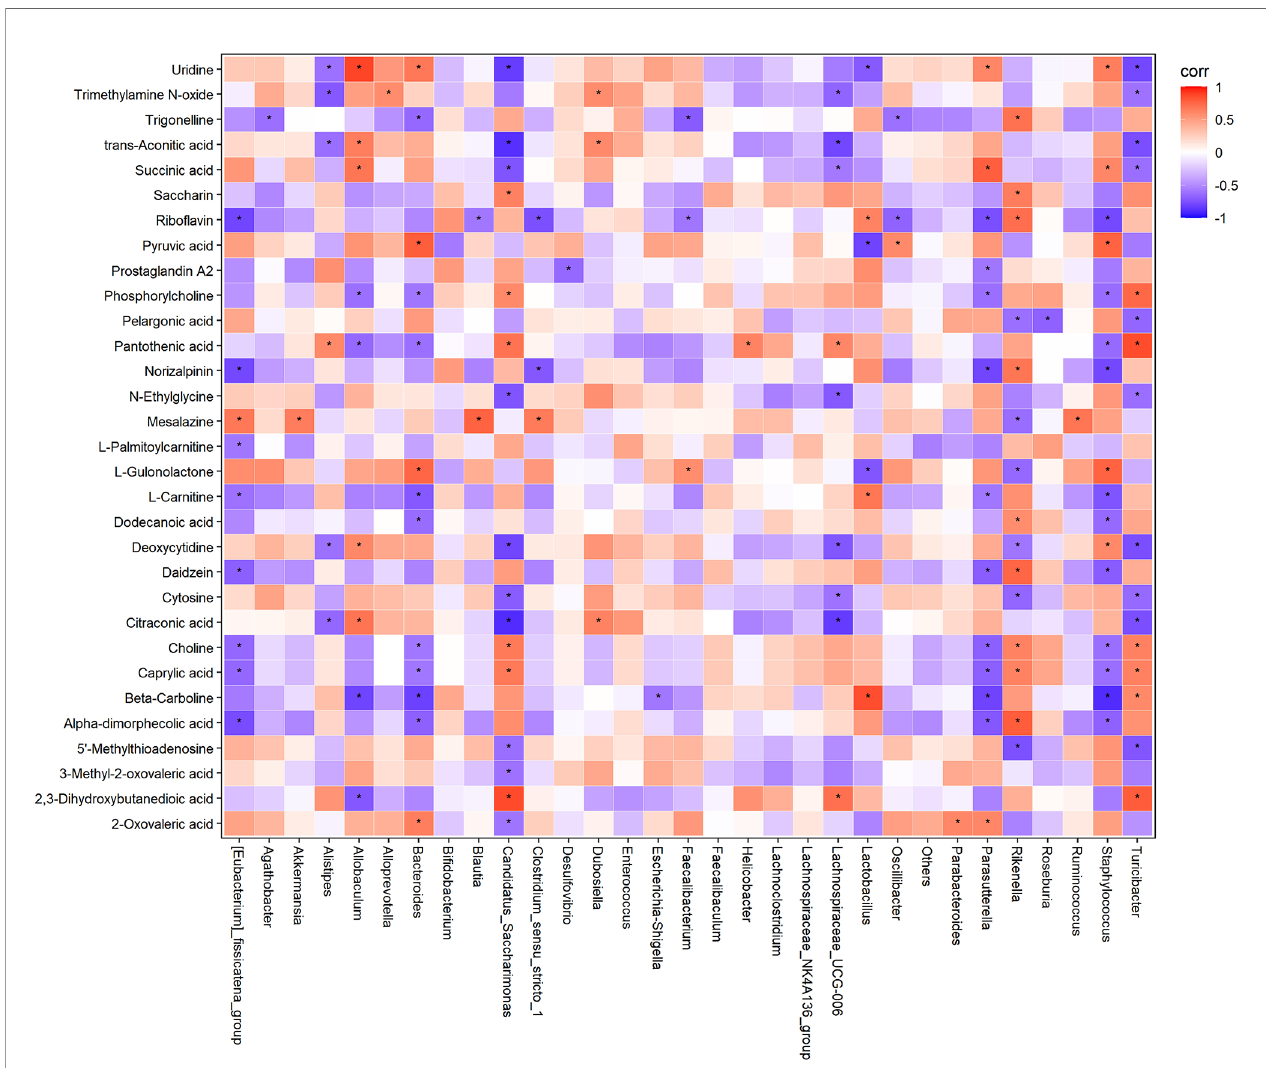
FIGURE 7 | Correlation analysis of gut microbiota and serum metabolites in HFD and HFD+policosanol mice. Red and blue indicate positive and negative correlations, respectively. *p <